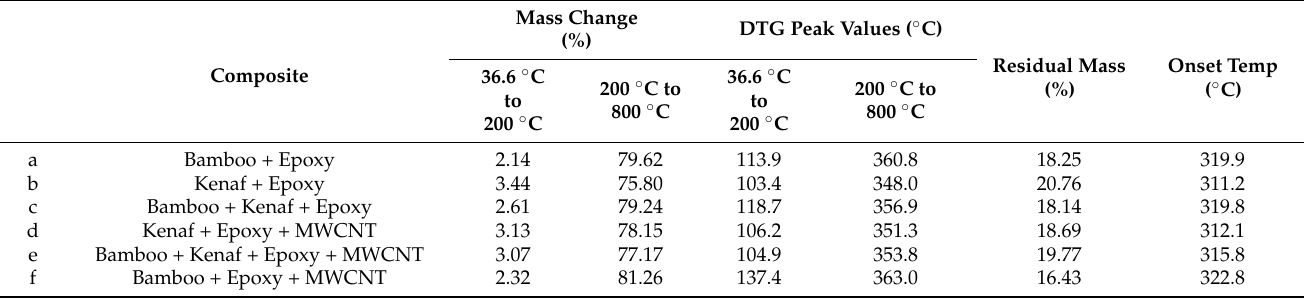
Figure 1. TGA and DTA curves of ( a ) Bamboo + Epoxy ( b ) Kenaf + Epoxy ( c ) Bamboo + Kenaf + Epoxy ( d ) Bamboo + Epoxy + MWCNT ( e ) Kenaf + Epoxy + MWCNT ( f ) Bamboo + Kenaf + Epoxy + MWCNT composites between 0 °C and 900 °C. Table 2. TGA/DTG data summary of Epoxy laminates consisting of natural fibres and/or MWCNT